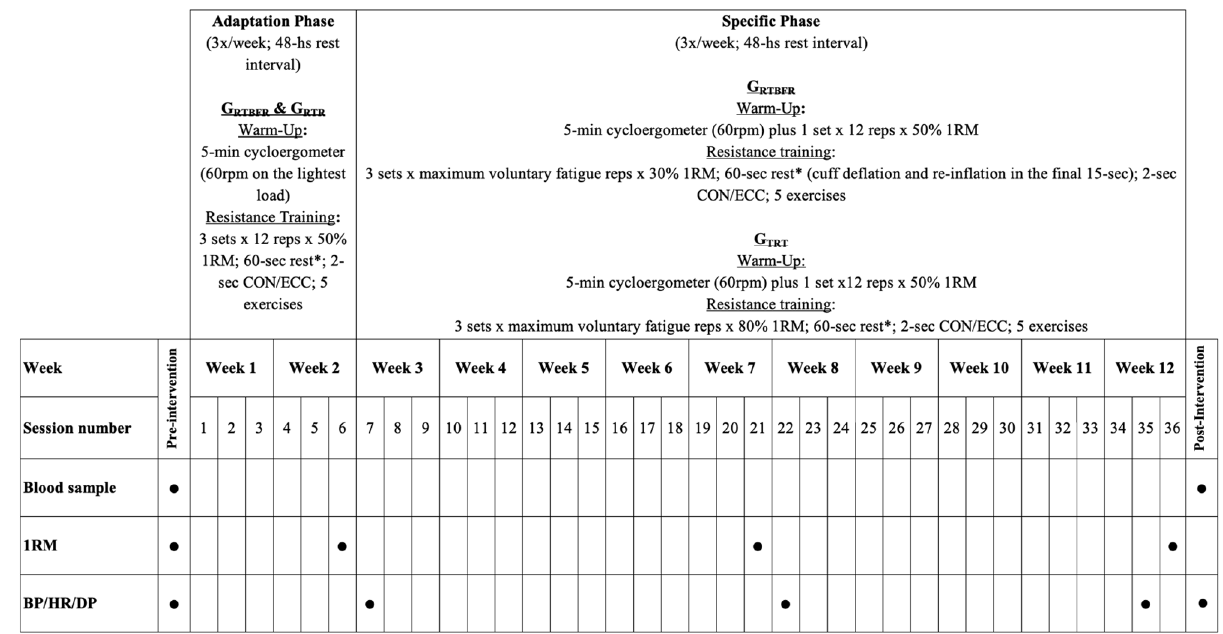
Figure 2. Training protocol and assessments during the intervention period. CON = concentric; ECC = eccentric; 1RM = one repetition maximum; BP = blood pressure; HR = heart rate; DP = double product; * = for each exercise and muscle grouping (upper or lower); A 3-min rest occurred in the transition between upper to lower limbs